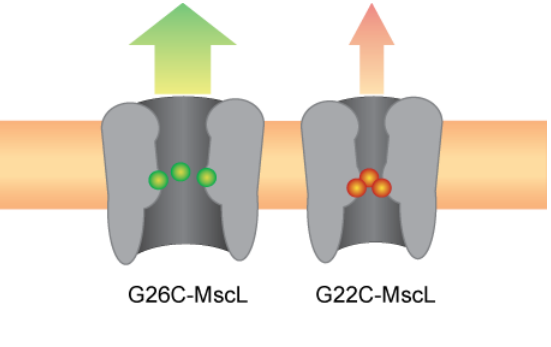
Figure 7. Improved efficiency of the MscL-based nanovalve; G26 is more accessible and stabilizes an open